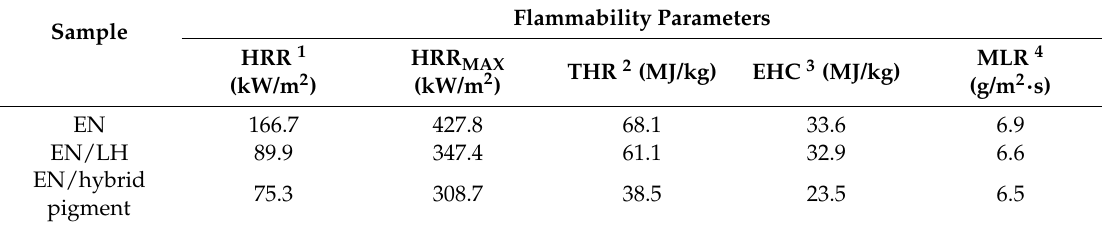
Figure 15. Chemical formula of carminic acid.